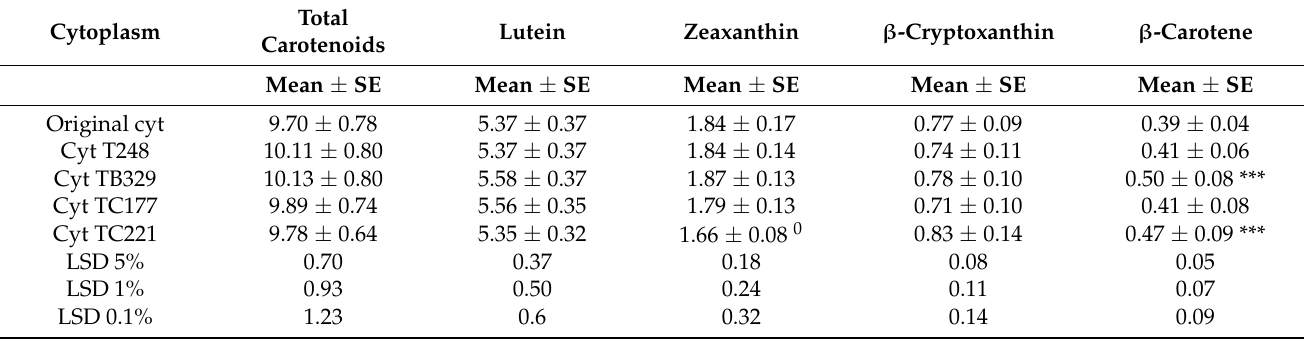
Table 2. Cytoplasm influence on carotenoid content for a group of isonuclear lines (µg/g)—ANOVA test.